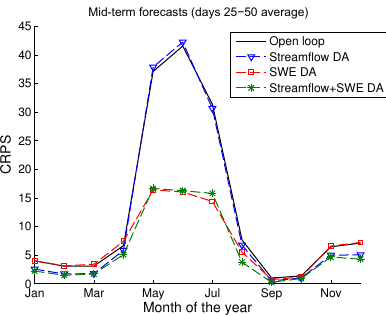
Figure 13. Continuous rank probability score for mid-term fore- casts (average of forecast horizons 25 through 50 days) of various data assimilation scenarios as a function of the month of the